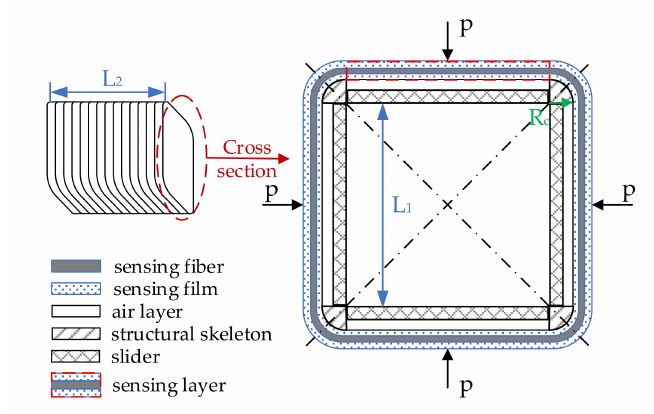
Figure 3. Structure of proposed cuboid-type